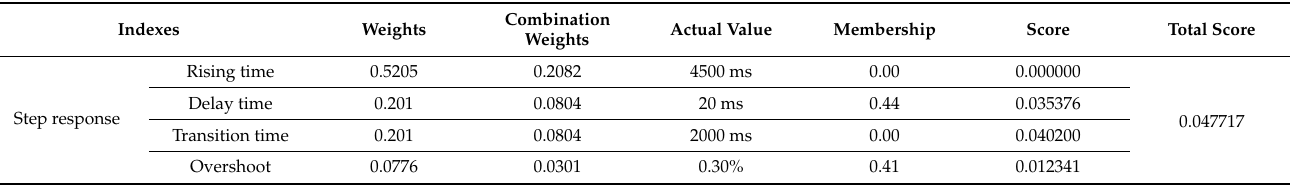
Table A6. Fuzzy PID controller displacement curve Evaluation